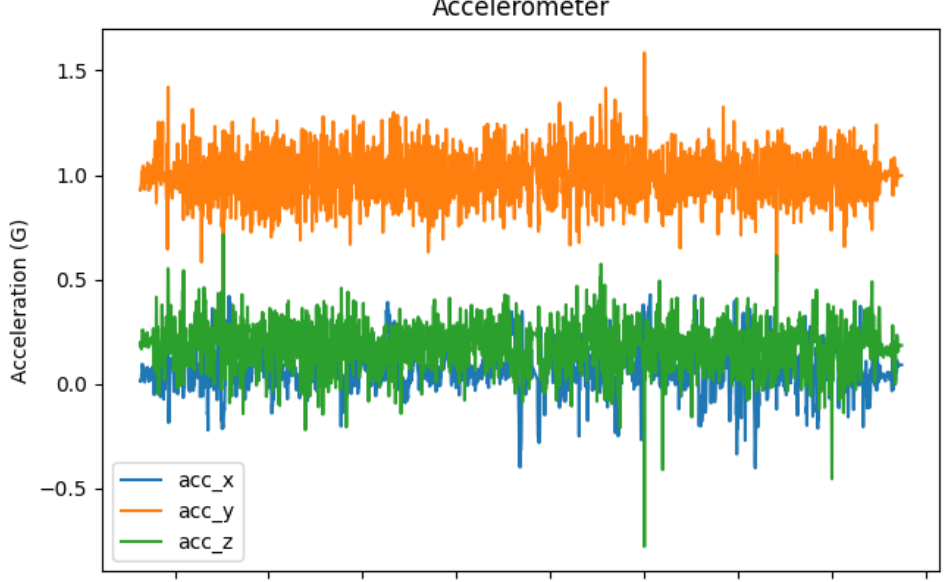
Figure 20. Acceleration of the smartphone in each axis (x, y, and z). With this setup, the Y axis corresponds to the vertical orientation, which is why it averages 1G (9.8 m/s2). With this orientation, the X corresponds to the horizontal orien- tation, increasing its values according to the sharpness of the turns performed, while the Z axis represents the depth, increasing its values with the actual acceleration of the